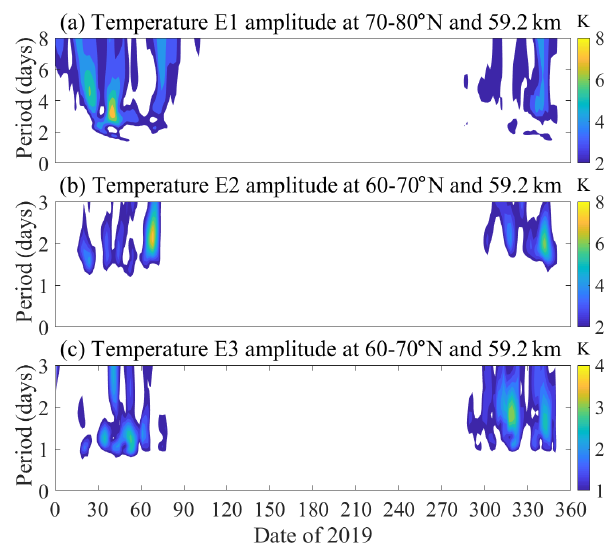
Figure 8. The temporal variations in (a) E1, (b) E2 and (c) E3 QT- DWs during the 2019 boreal winter period. The date indicates the day of the